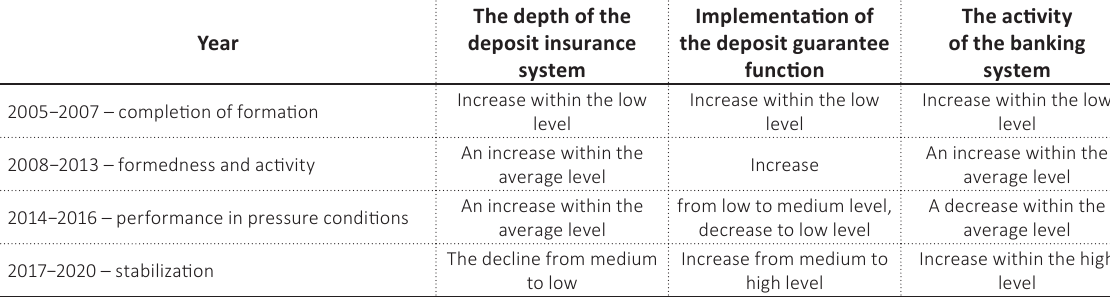
Table 3. Dynamics of the components that shape the development of deposit